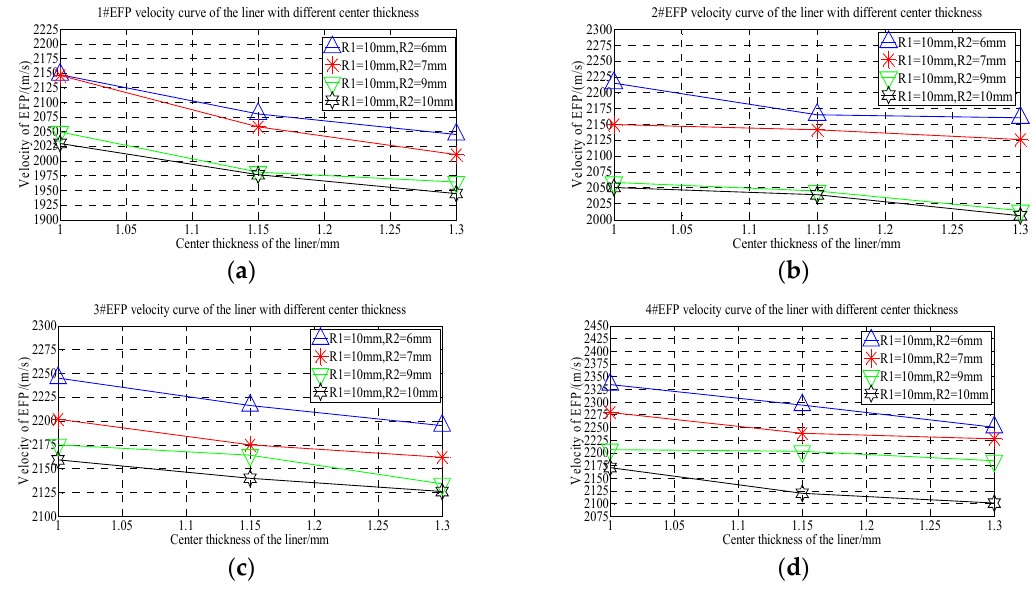
Figure 12. 1#EFP-4#EFP velocity curve of the center of the liner with different thickness: ( a ) 1#EFP velocity curve; ( b ) 2#EFP velocity curve; ( c ) 3#EFP velocity curve; ( d ) 4#EFP velocity curve.